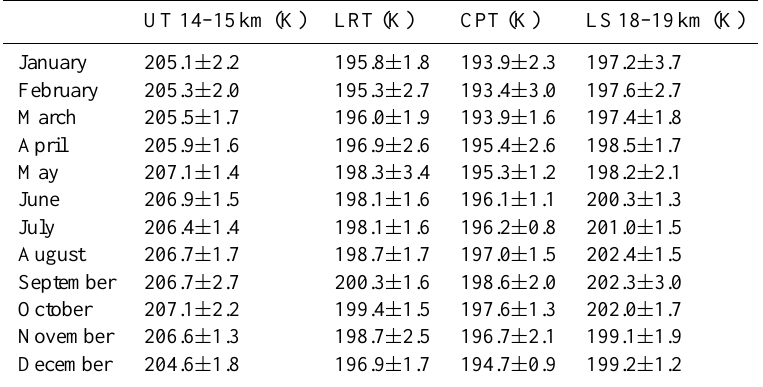
Table 1. Monthly mean climatological temperature and corresponding standard deviations (in Kelvin) at UT, LRT, CPT and LS from radiosonde data collected at Reunion from January 1993 to December 2008.